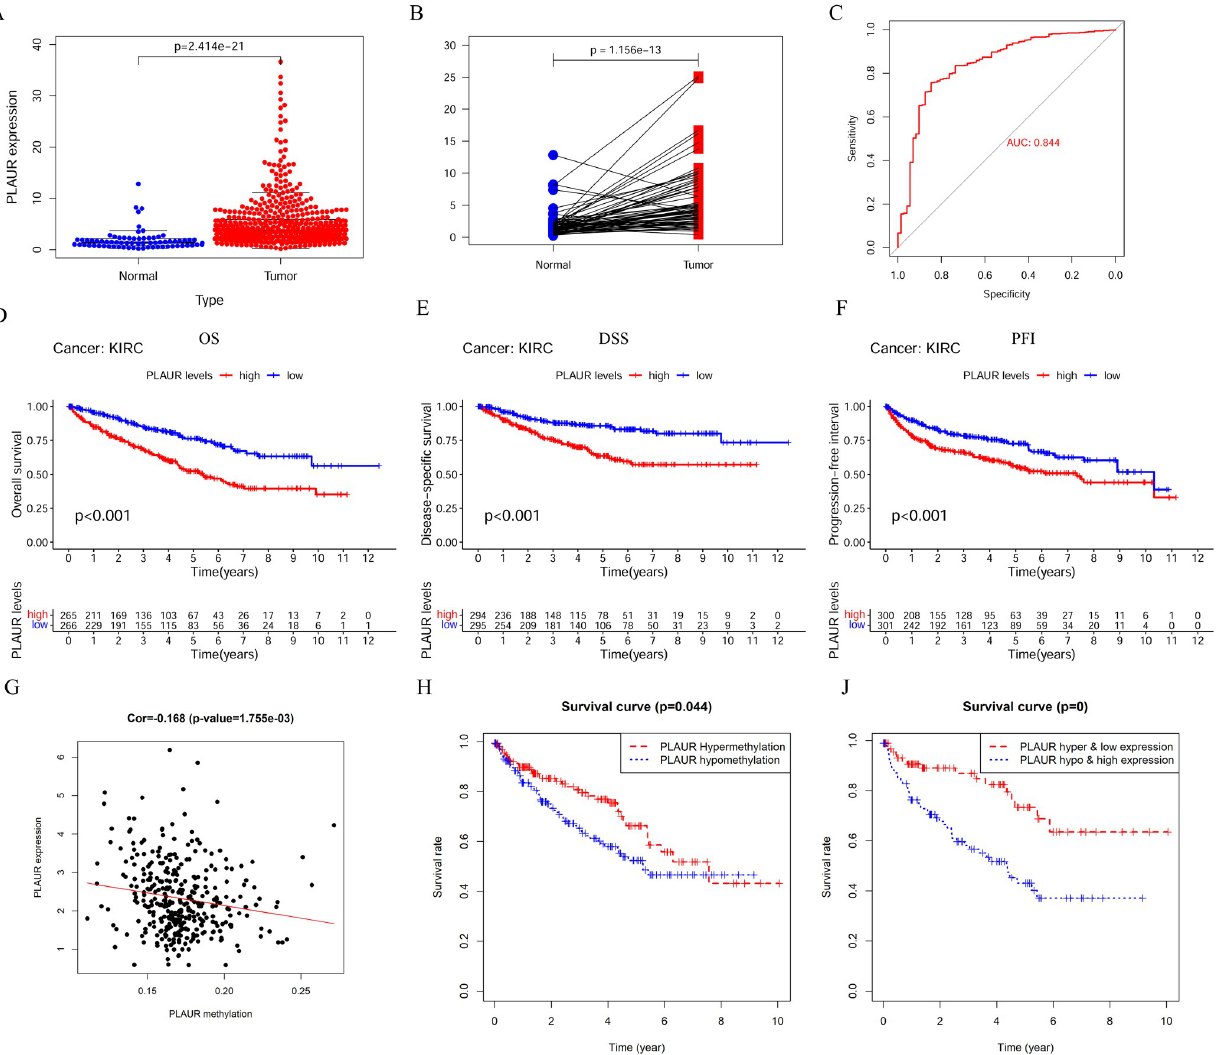
Fig 2. Expression of PLAUR in ccRCC and methylation study. A-F. Analysis of PLAUR expression and prognosis in ccRCC; G-J. Analysis of methylation levels and prognostic correlation of PLAUR in ccRCC.